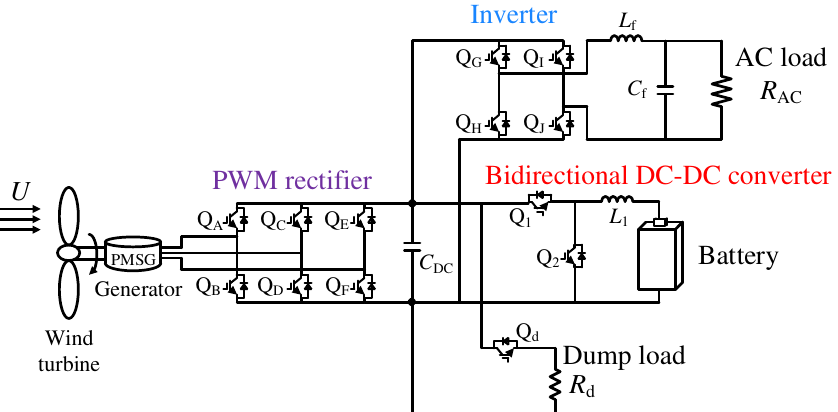
Figure 2. Standalone WPGS with PWM rectifier and non-isolated bidirectional DC-DC converter in